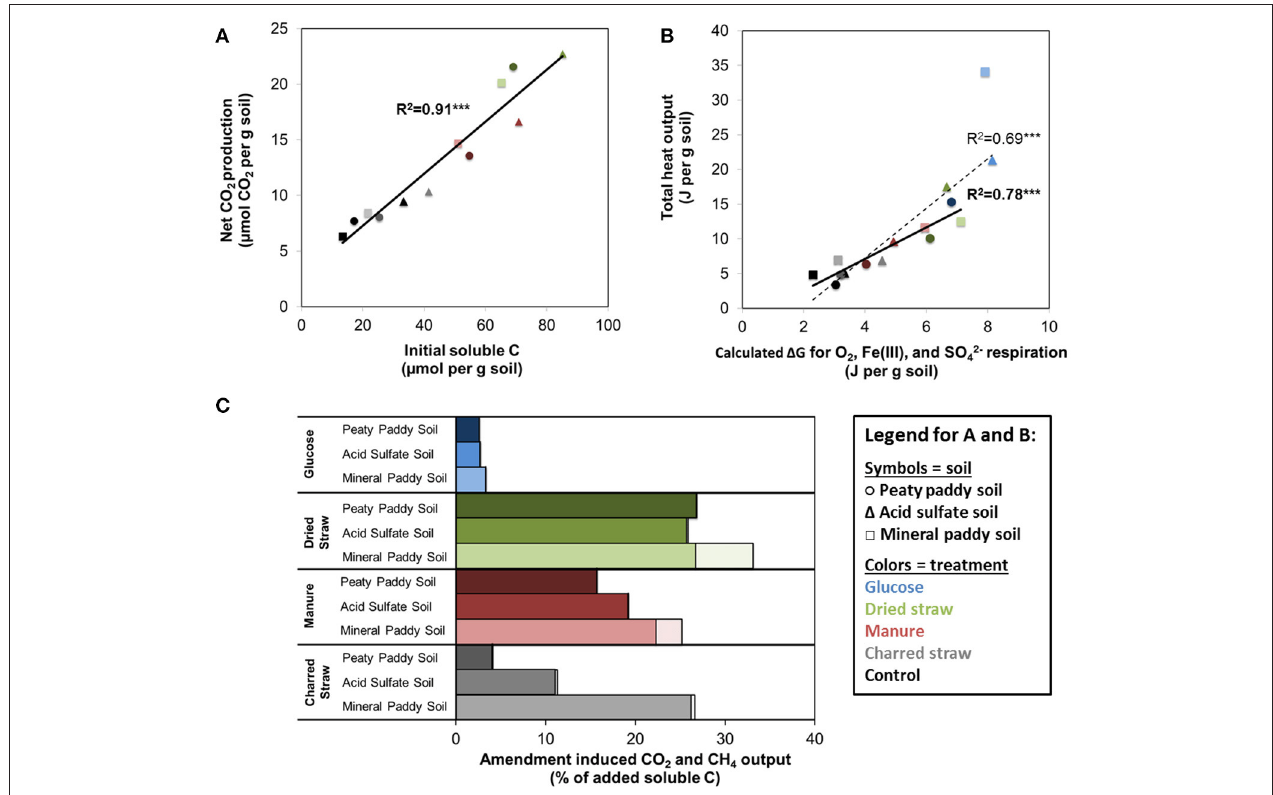
FIGURE 5 | Relationship between (A) initial amount of water soluble C and total respiration ( µ mol per g soil), excluding glucose treatment, and (B) total heat dissipation during the incubation (J per g soil) and the calculated Gibbs free energy of respired C, calculated from average NOSC of initial water soluble C and the fraction of this C that was respired with O 2 , Fe(III), and SO 2 − 4 (assuming NOSC-unbiased utilization and complete oxidation to CO 2 , using stoichiometric balances and values from Table 1 ). In both (A,B) soils are represented by different symbols and shades (light (cid:3) = mineral paddy soil, medium 1 = acid sulfate soil, dark ◦ = peaty paddy soil) and the colors correspond to treatments: Control, black; CS, gray; M, red; DS, green; Gluc, blue. Linear regression fits and R 2 - values are shown in solid and bold for fits excluding glucose and dashed, normal font (B) for fit including glucose. (C) shows total amendment induced output of CO 2 (solid) and CH 4 (light, shaded) as % of added water soluble C.